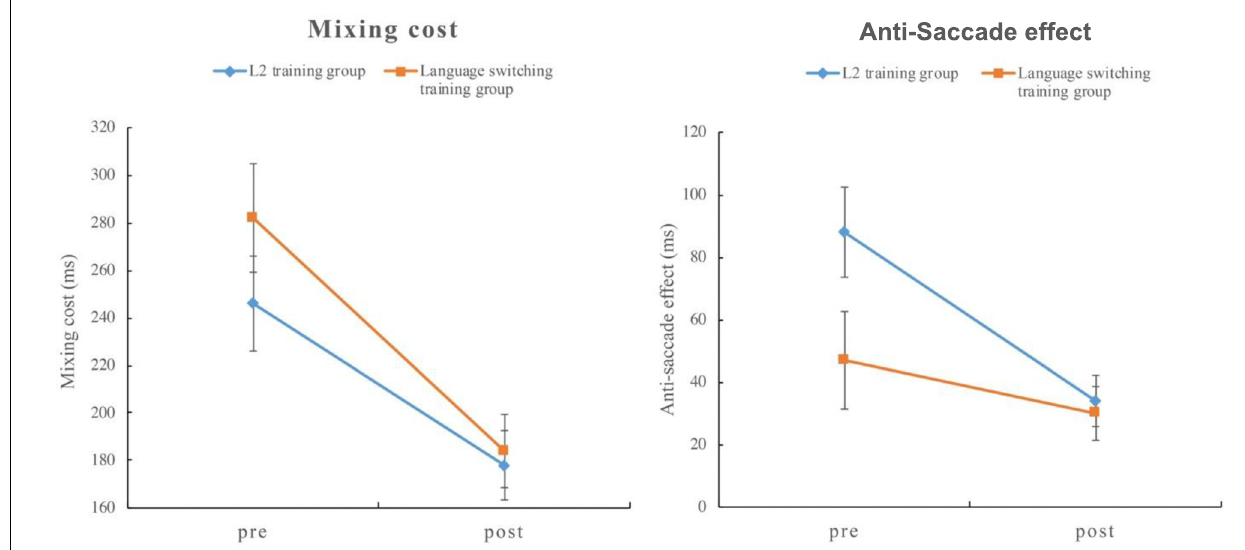
FIGURE 2 | Mixing costs of the color-shape switching task (left) and anti-saccade effect of the anti-saccade task (right) in Experiment 2. The error bar represents standard error.